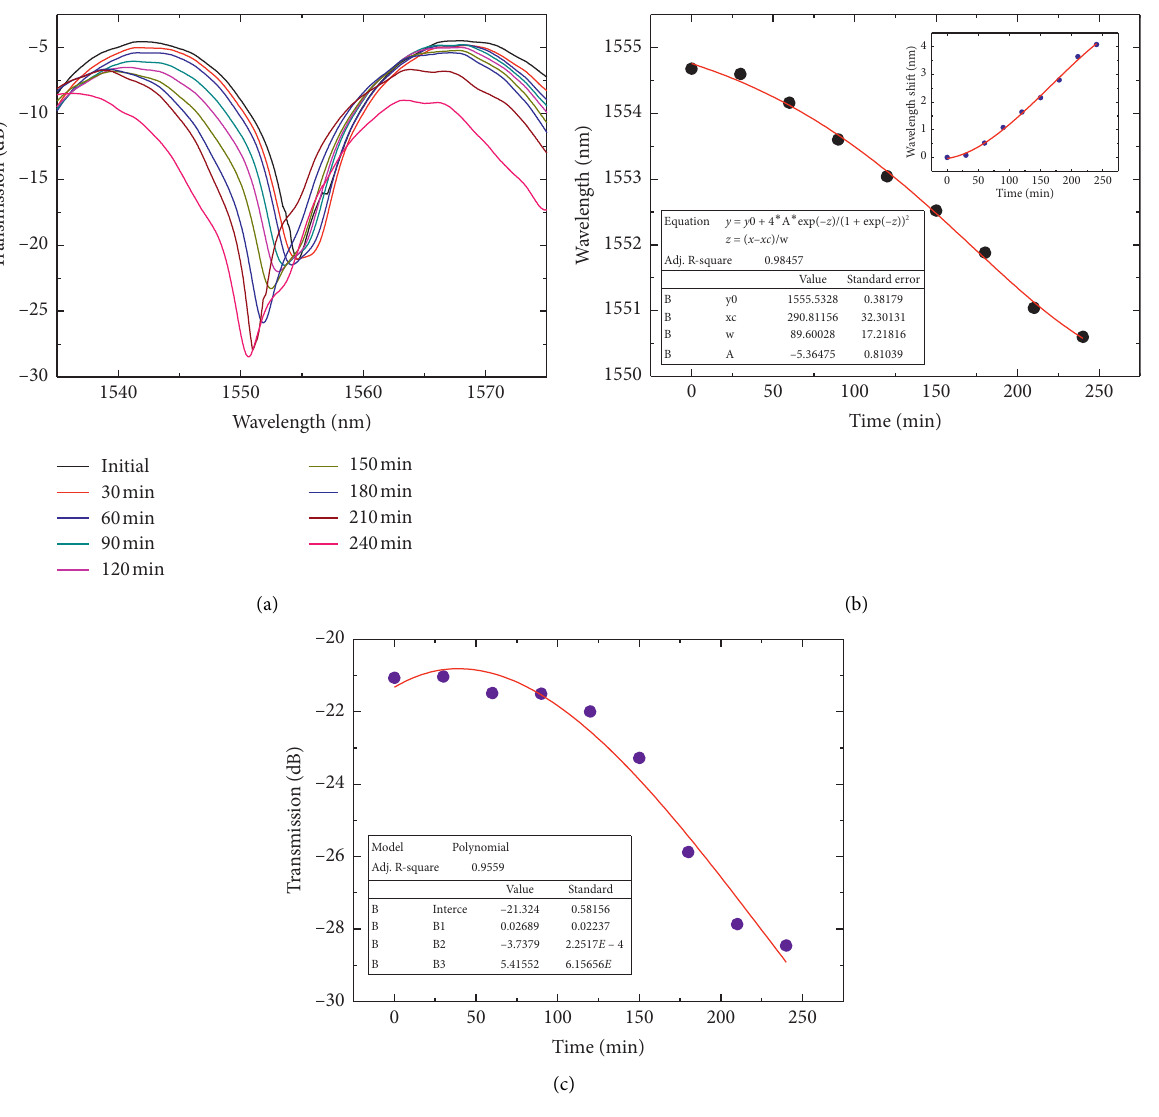
Figure 3: (a) Measured spectral responses during the first 4 hours, which was recorded every 30min; the wavelength shift (b) and transmission loss (c) during the first 4 hours, which were caused by the change of the bacterial